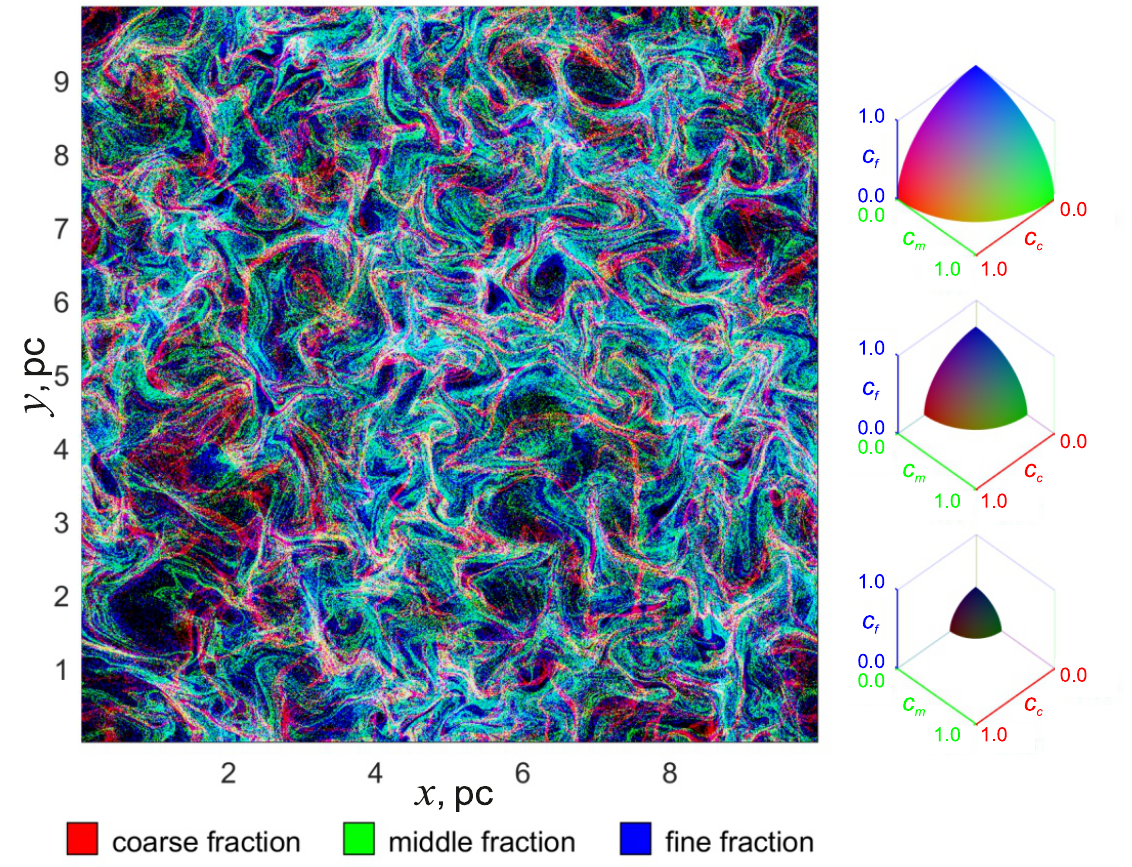
Figure 3. Synthetic image of polydisperse dust, consisting of three fractions, for the same time point as in Figure 2. The total number of particles in each fraction is the same. The red color corresponds to the dominance of the concentration of large dust particles: green, medium-sized dust; blue, small dust particles. All other colors correspond to a mixture of fractions in various proportions (for a detailed explanation of the procedure for calculating the color, see Section 3). Three plots on the right side demonstrate color palettes on the surfaces of the color cube’s section by a sphere = C 2 , where C = 1/3 (bottom panel), 2/3 (middle panel) and 1 (upper c 2 c + c 2 m + c 2 f